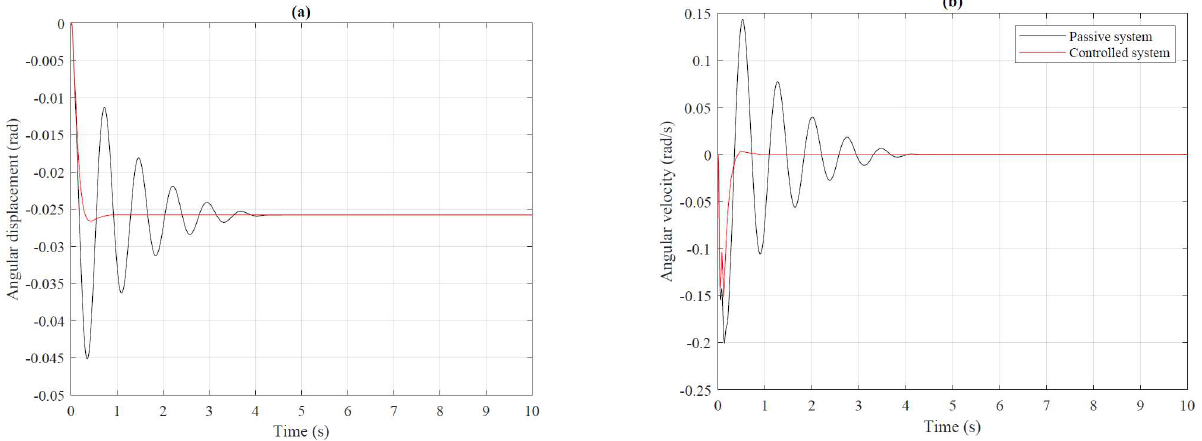
Figure 9. Angular displacement ( a ) and angular velocity ( b ) of the body moving about an axis running from left to right (pitch).